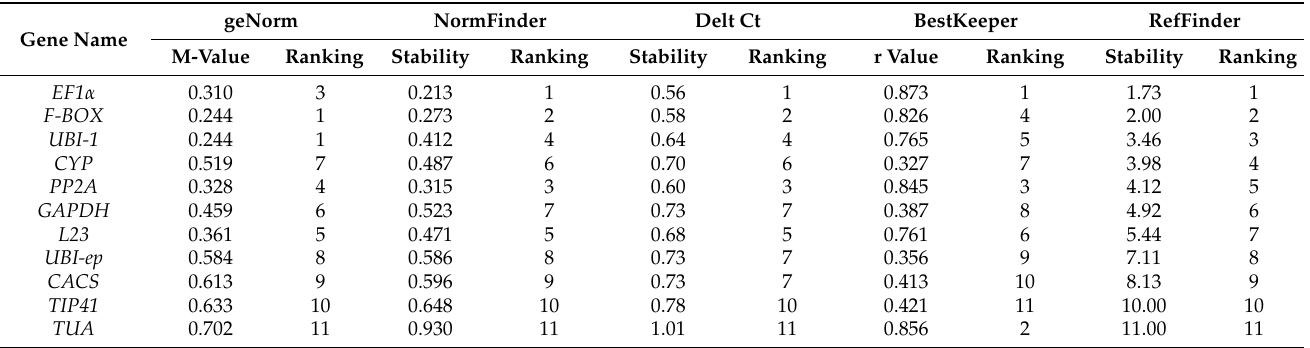
Table 2. Expression stability ranking of the nine candidate reference genes calculated by four different types of software. M-value: stability measurement; r: coefficient of